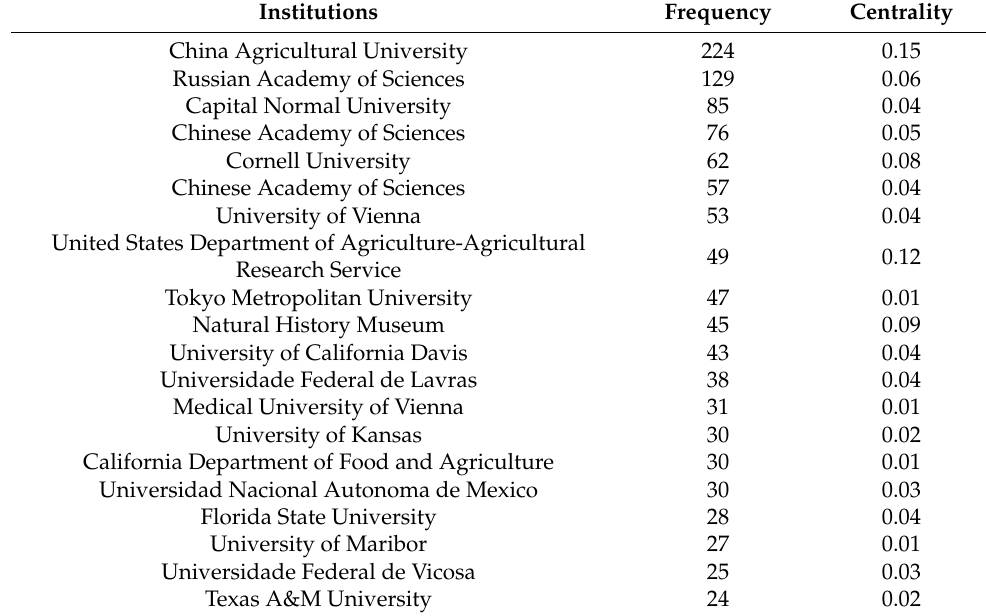
Table 6. Top 20 institutions based on occurred